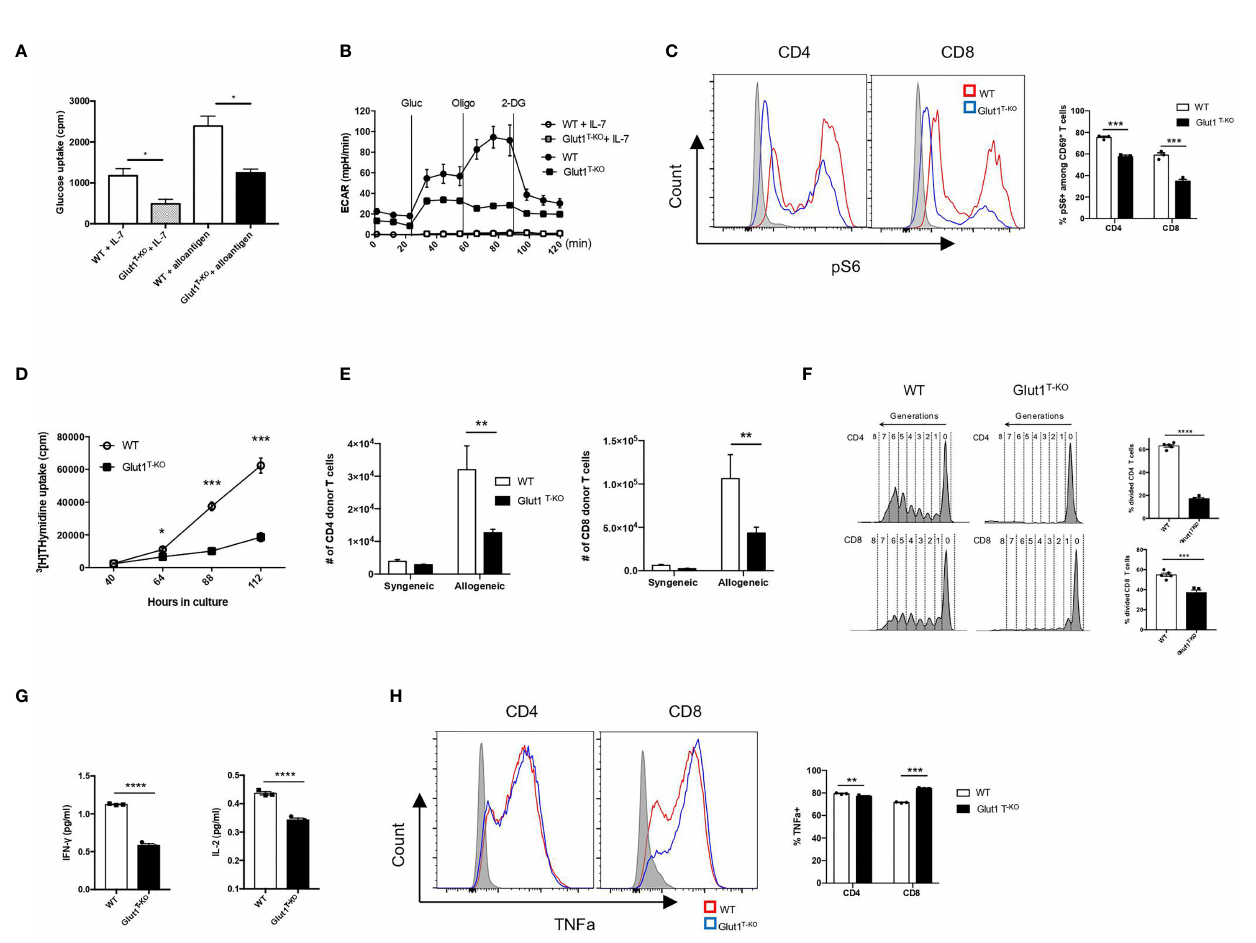
FIGURE 2 | Glut1 mediates the expansion of alloreactive T cells. WT or Glut1 T-KO T cells were stimulated with BALB/c dendritic cells. After 5 days in culture, glucose uptake was measured (A) . ECAR was assessed with the addition of glucose (gluc), oligomycin (olig), and 2-DG (B) . WT or Glut1 T-KO T cells were stimulated for 16 hours using BALB/ c DCs and analyzed by fl ow cytometry for phospho-S6 levels in CD69 + T cells (C) . Expansion in vitro was measured by 3 H-TdR incorporation assay at indicated time points after culture (D) . Expansion in vivo was measured in T cells isolated from the spleen seven days after transplantation with 1 x 10 7 TCDBM from B6.SJL donors and 1 x 10 6 WT or Glut1 T-KO T cells on the C57BL/6 background into BALB/c recipients (E) . T cell proliferation following isolation from the spleen was analyzed (left panel) and measured by frequency (right panel) 58 hours following transfer of CellTrace Violet (CTV)-labelled T cells along with B6.SJL TCDBM into BALB/c recipients (F) . IFN g and IL-2 production were assayed by ELISA using supernatants from T cell cultures (G) . (H) WT or Glut1 T-KO T cells were stimulated with puri fi ed BALB/c DCs for 72 hours, with the addition of PMA (20ng/ml), ionomycin (1uM), and monensin 4 hours prior to intracellular staining for TNF a . Data are representative of two (F, n = 3) or three experiments (n = 3, A-D, and G; n = 5, E and F) and are shown as mean ± SEM (B – F) . *P < 0.05, **P < 0.01, ***P < 0.001, ****P < 0.0001 (Glut1 T-KO vs. WT), 2-tailed Student t